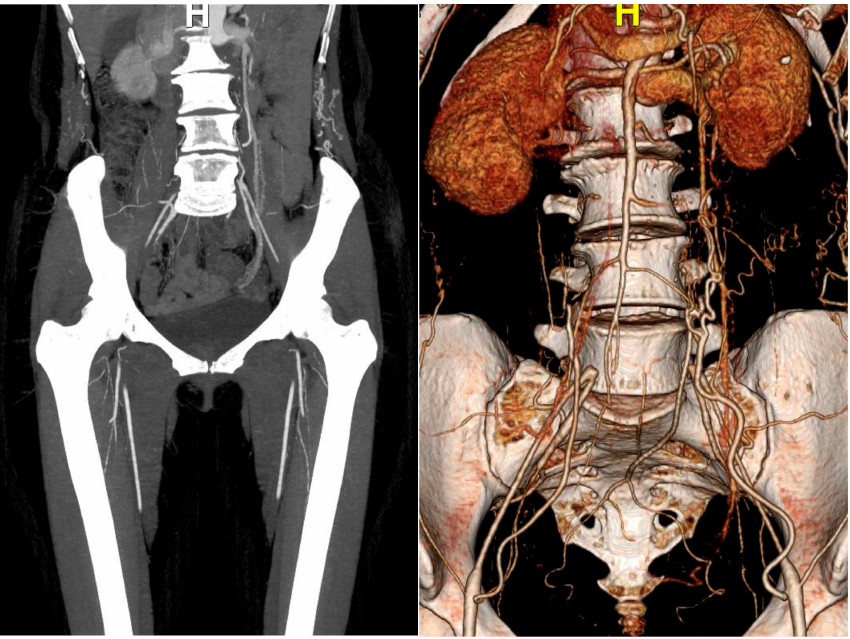
Figure 4. Lower-extremity computed tomography angiography: Total occlusion between the in- frarenal abdominal aorta and the bilateral common iliac